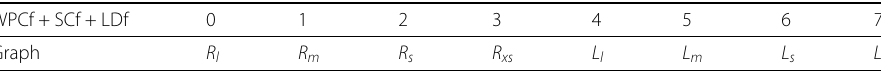
Table 1 Underlying networks for different combinations of school and workplace closing levels and lockdown restrictions. A lower level entails less restrictions, increasing up to 7, which represents the full lockdown situation